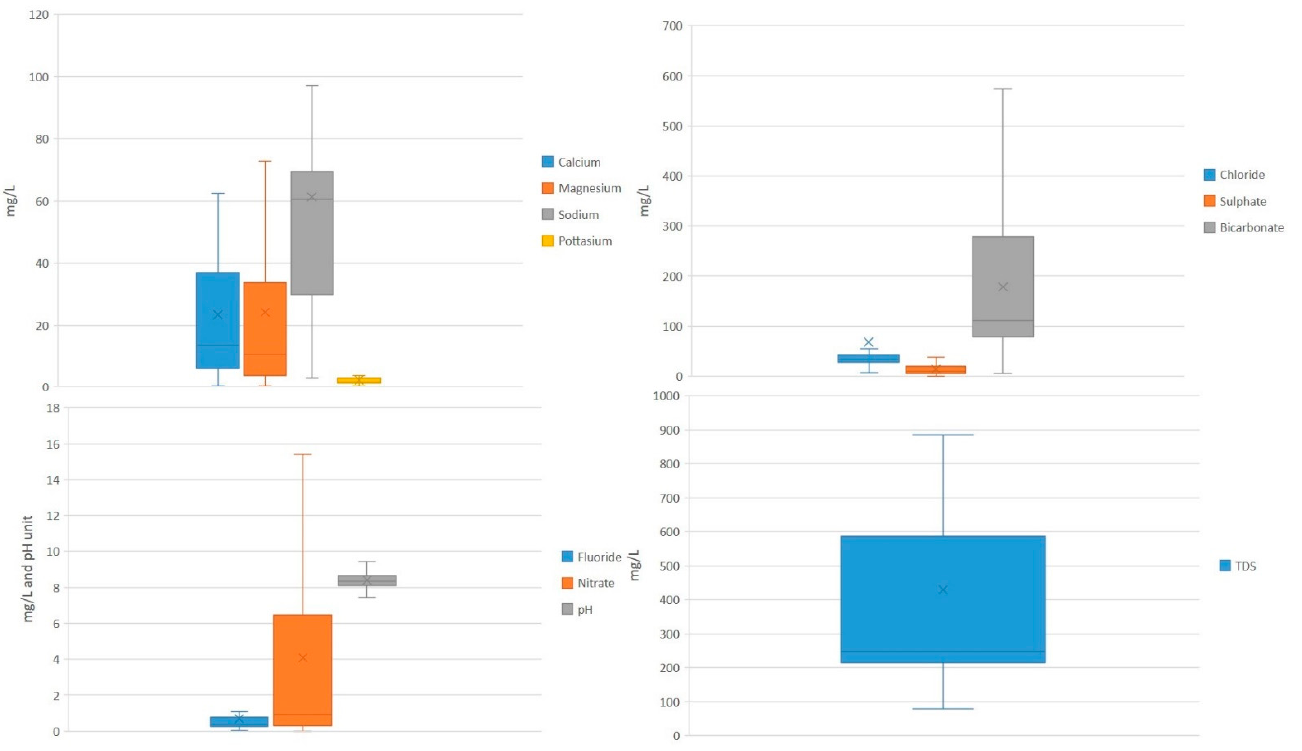
Figure 2. Box and whisker plots of various parameters. Table 3. Classification of groundwater based on TDS [42].